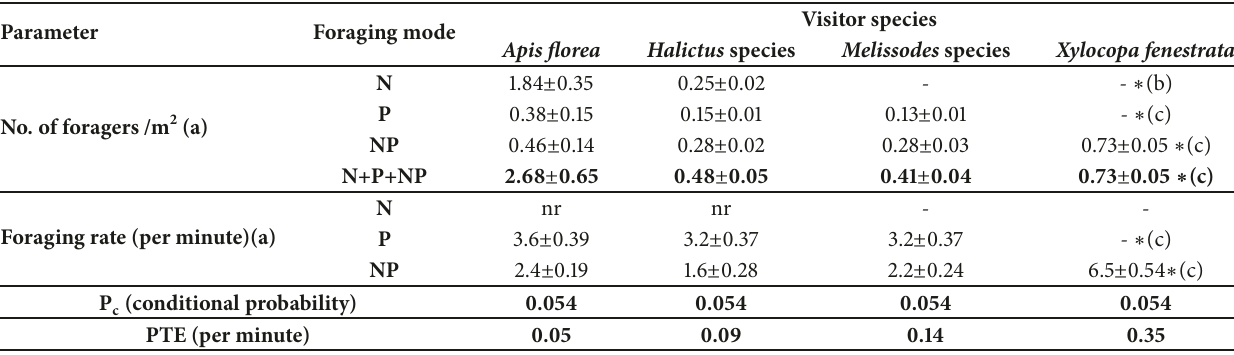
P c : derived from D : C ratio = 4138 : 253. Other abbreviations are as in Table 5. bath sponge it was X. fenestrata > Melissodes sp. > Halictus sp.